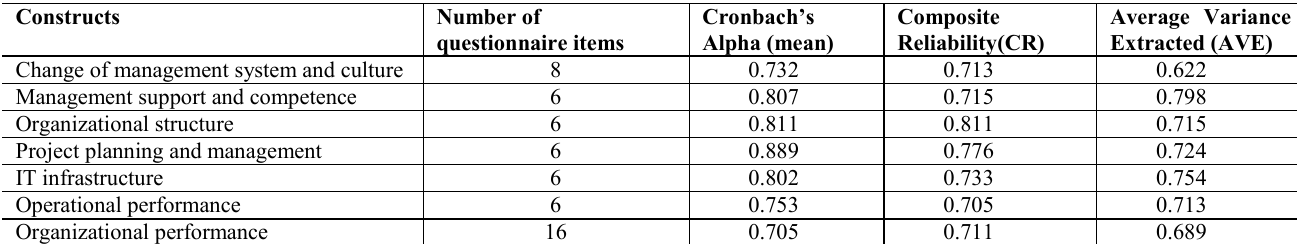
Table 3: Summary of test result-reliability analysis